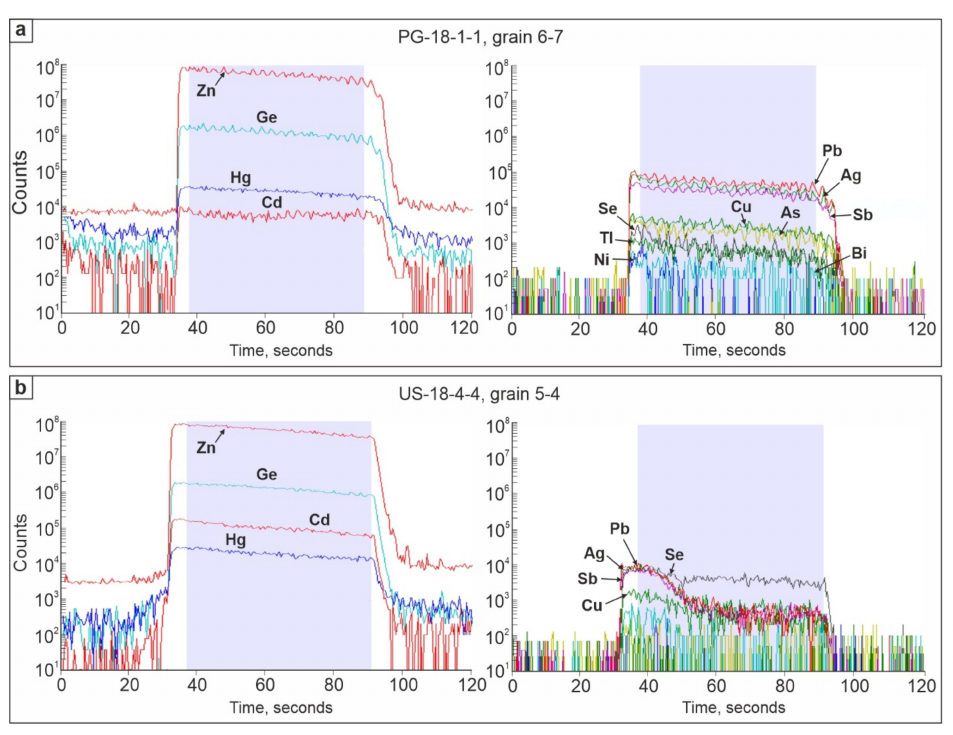
bdl = below detection limit; - = not measured.